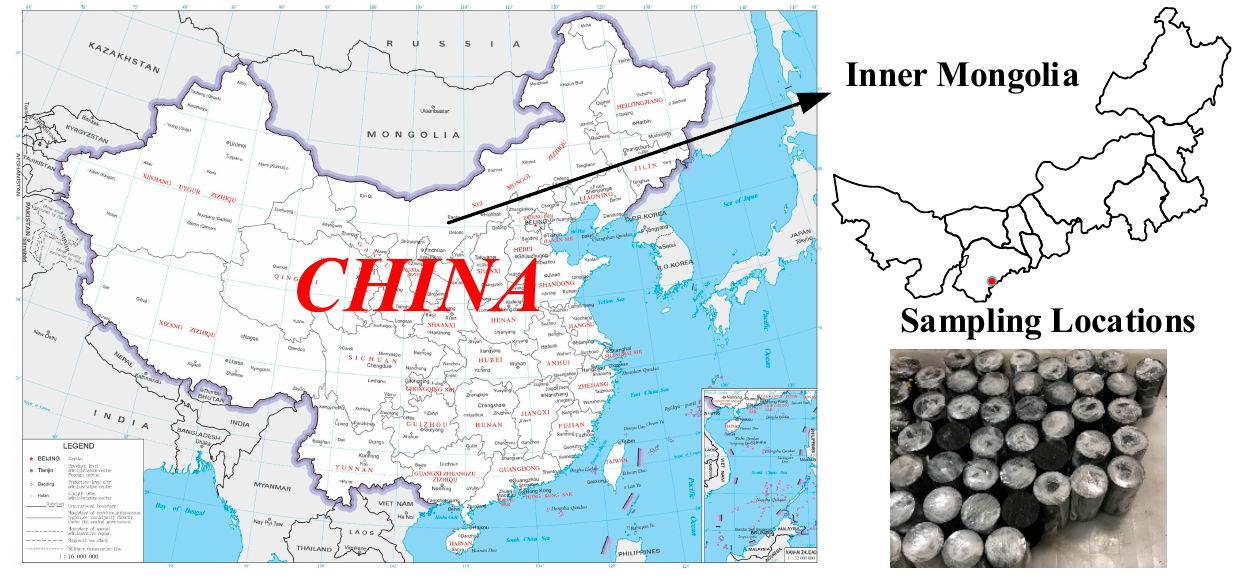
Figure 3. Map of the sample sites.